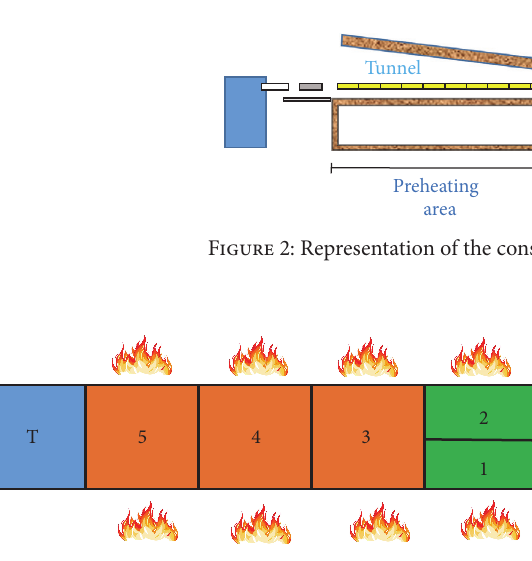
(iii) Soaking Area . In this last furnace area, the billets com- plete their reheating process. Here, temperatures vary approximately in the range 1100[ ∘ C]–1250[ ∘ C] and the total length is 5 [m]. The furnace area, equipped with 24 burners, is transversally divided into two zones, denoted as zone 2 and zone 1 (Figure